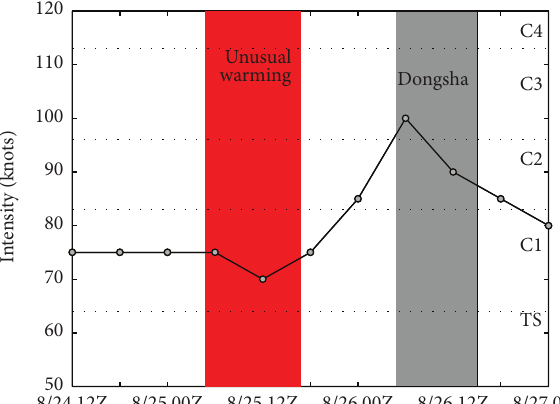
Figure 2: Correspondent time series of TC intensity change during Tembin’s rapid intensification and following TC intensity weaken- ing.